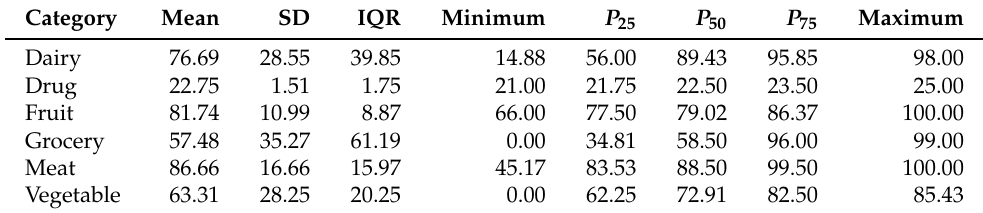
Figure 2. Scheme of a computer application to register system demands and costs of products and to forecast stochastic lot sizes in pharmacies and FNS. Table 5. Descriptive statistics for saving of inventory cost (in %) by category.